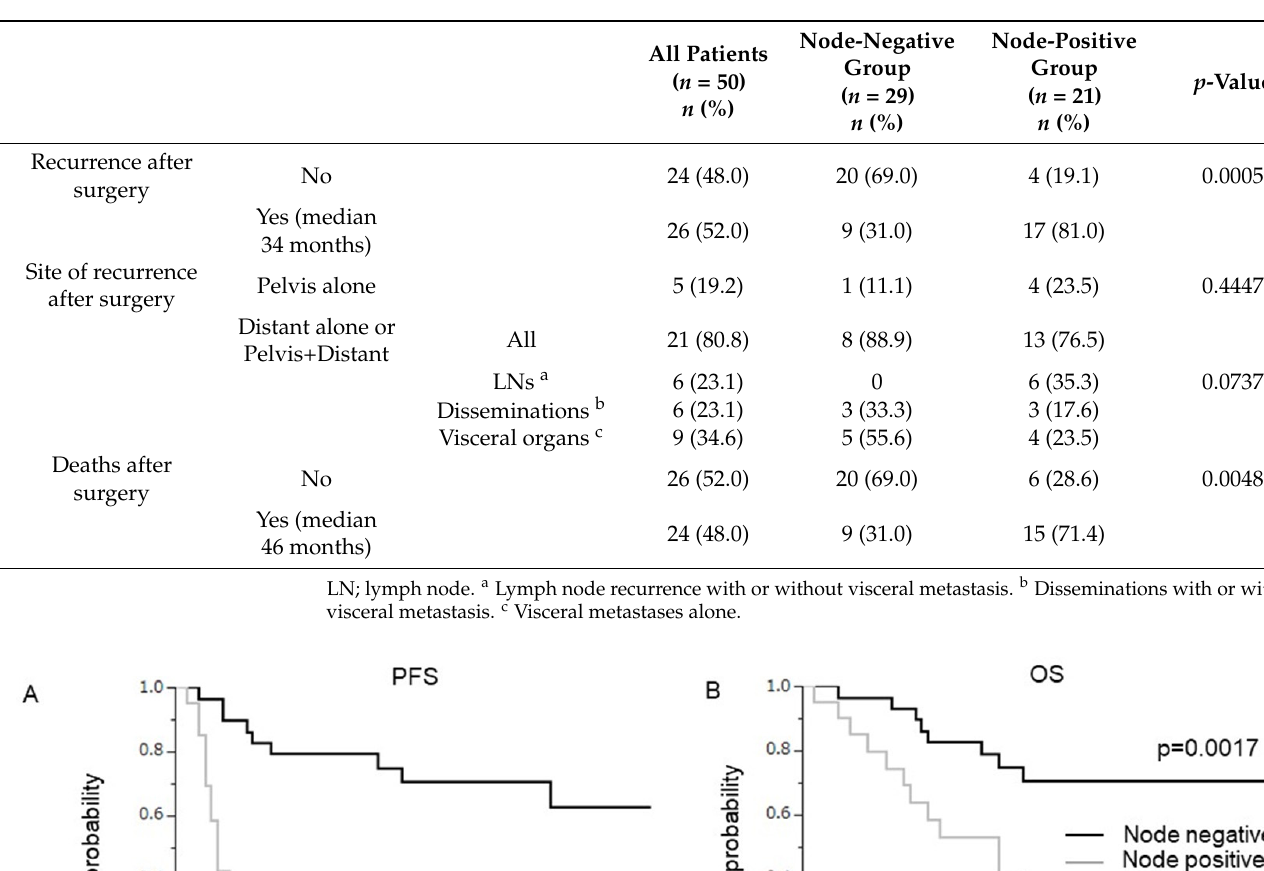
Table 2. Treatment outcomes.